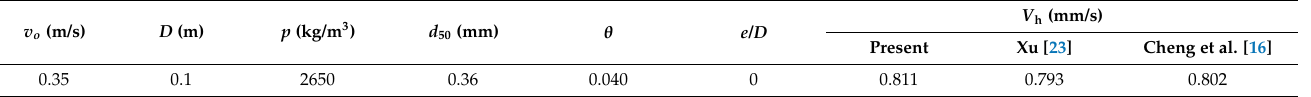
Figure 3. Comparison of scour hole profiles below the pipeline: ( a ) t = 10 min; ( b ) t = 30 min; ( c ) t = 200 min.